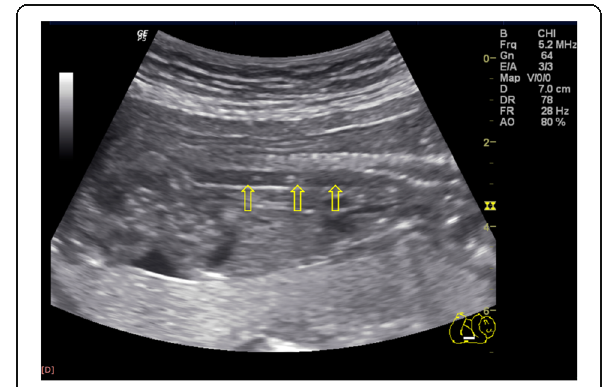
Fig. 4 Post-termination photograph of the abortus shows marked micromelia, relatively large head, narrow thorax, and distended abdomen. Bilateral clubfeet are also